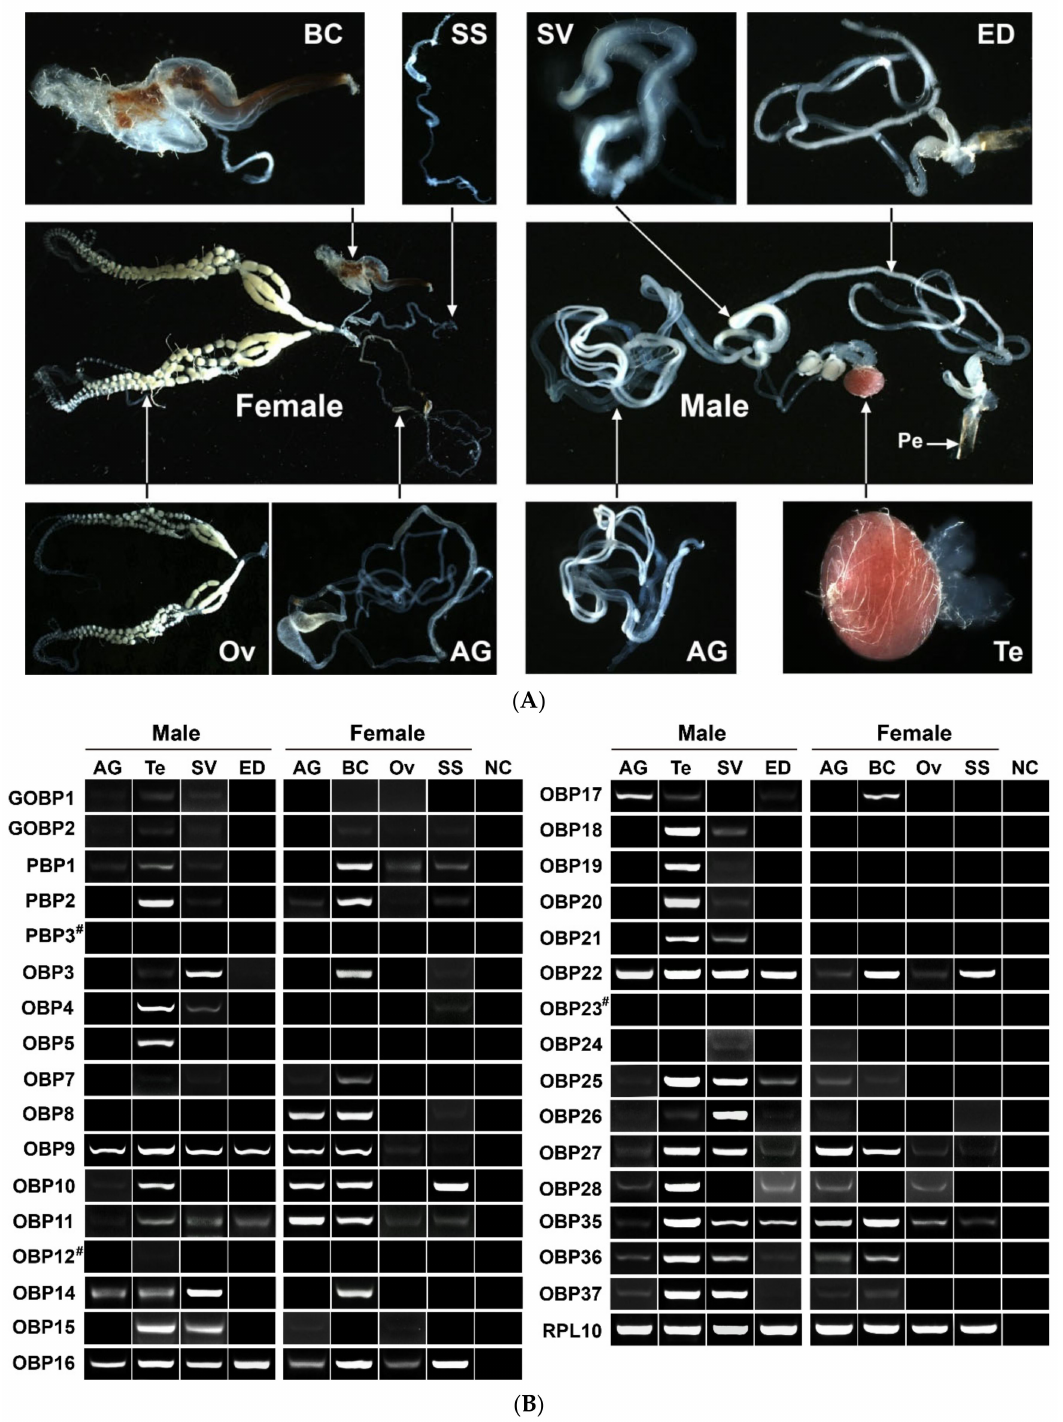
Figure 1. Expression profiles of DabiOBPs in eight reproductive tissues of D. abietella adults. ( A ) Re- productive systems of female and male adults. ( B ) Expression profiling analyses of 32 DabiOBPs in reproductive tissues. A control gene, DabiRPL10, was used to check the quality and integrity of the templates. AG, accessory glands; BC, bursa copulatrix; Ov, ovaries; SS, spermathecae with spermathecal glands; ED, ejaculatory ducts; SV, seminal vesicles and Te, testes. NC, negative control using sterile water as the template. # means that the transcription of genes was not detected in reproductive tissues. The original gel images are given in Supplementary Materials File